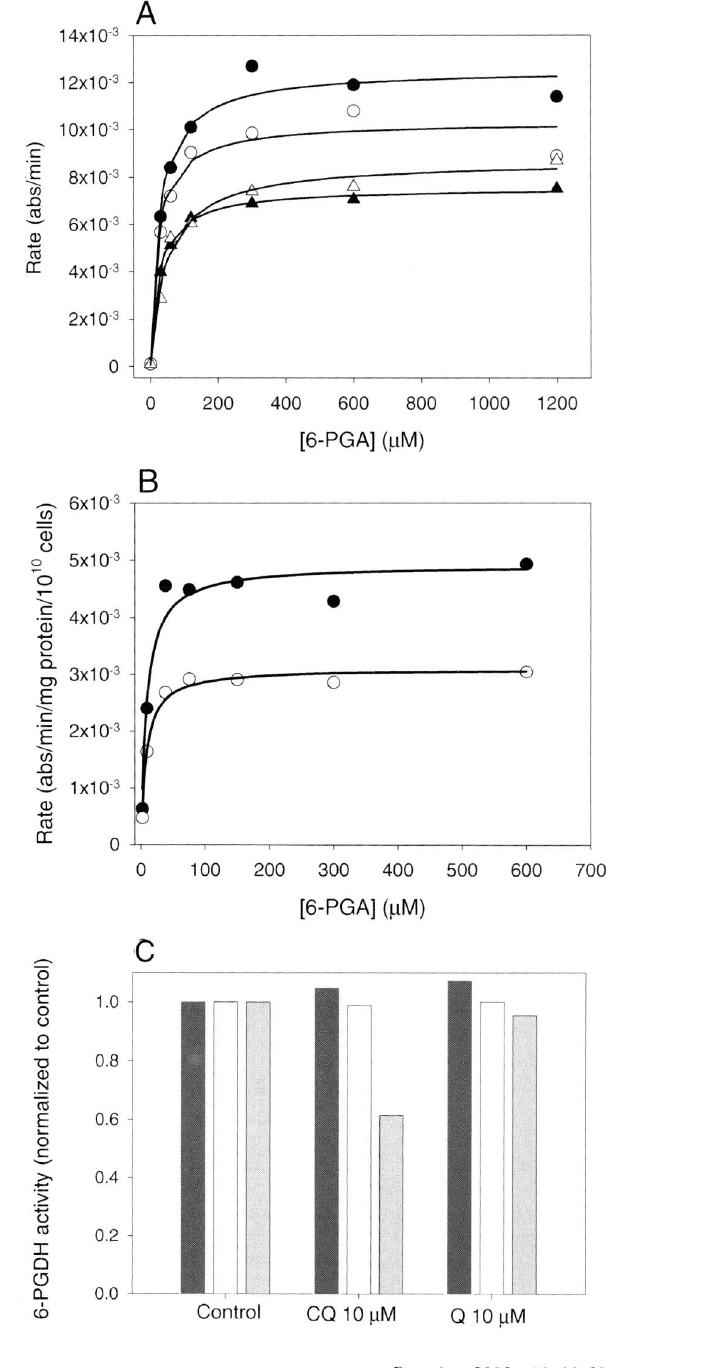
Fig. 5. - Inhibition of 6-phosphogluconate dehydrogenase activity by FFIX. Enzyme activity in lysates in absence and in presence of increasing FPIX concentrations was determined as described in Materials and Methods. A. Enzyme activity of erythrocyte lysate was characterized by deriving Km (uM) and Vmax (x10 -3 absorbance units/min) values, respectively: Control - • (filled circles) - 28.3 ± 7.1; 12+9. [FPIX] = 0.5 µ.M - O (empty circles) - 23.4 ± 7.8; 10.2 ± 0.9. [FPIX]